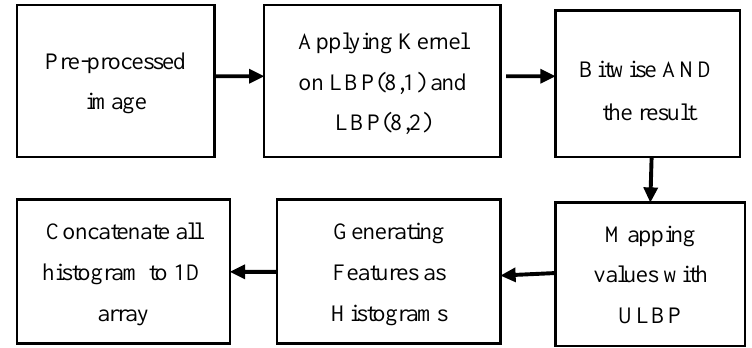
Figure 4. Feature extraction process.